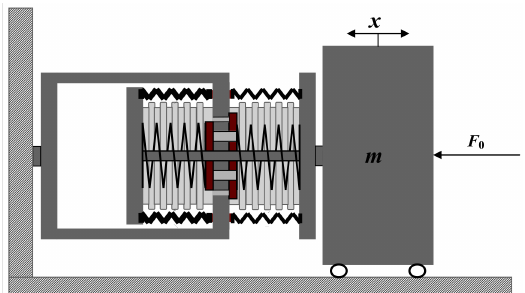
Figure 6. PWL system for mitigation the dynamic forces transmitted from the sprung mass to the system